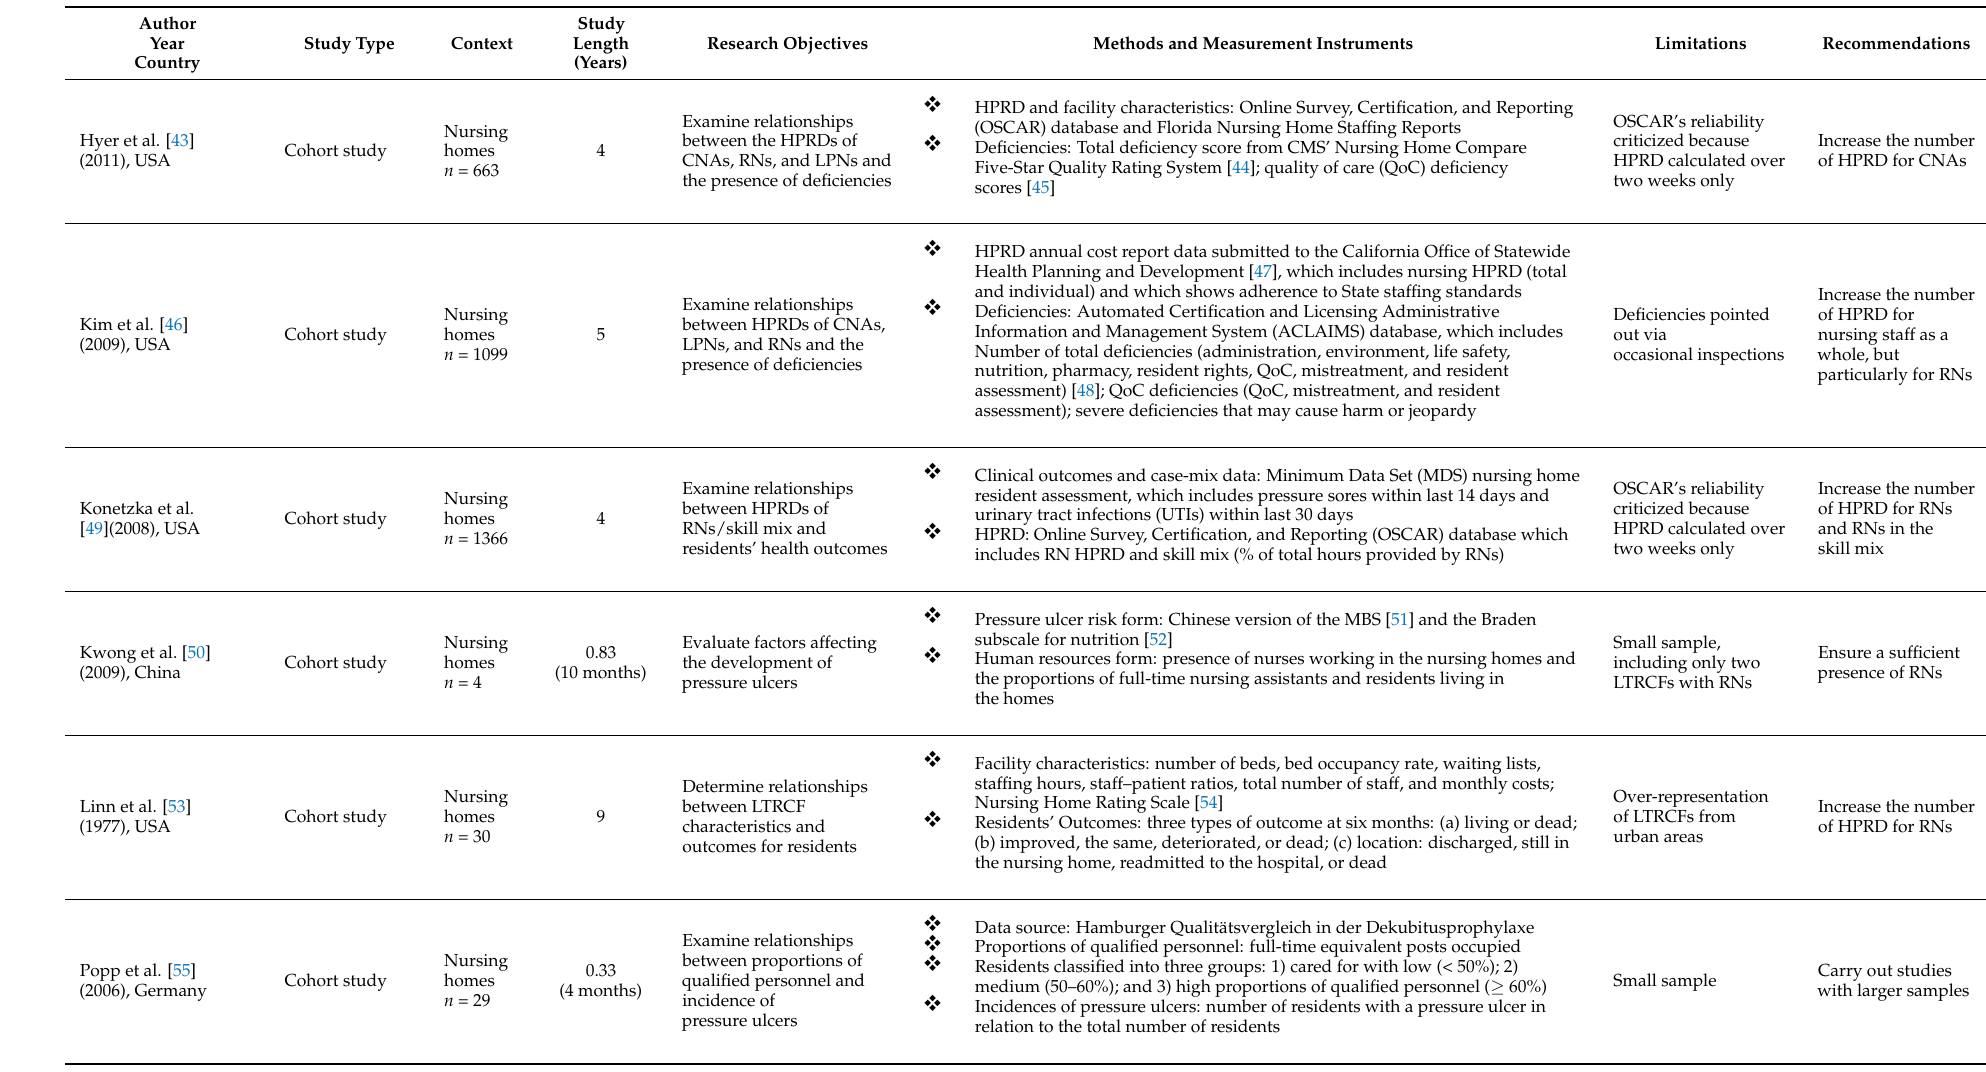
Table 1. Characteristics of the included